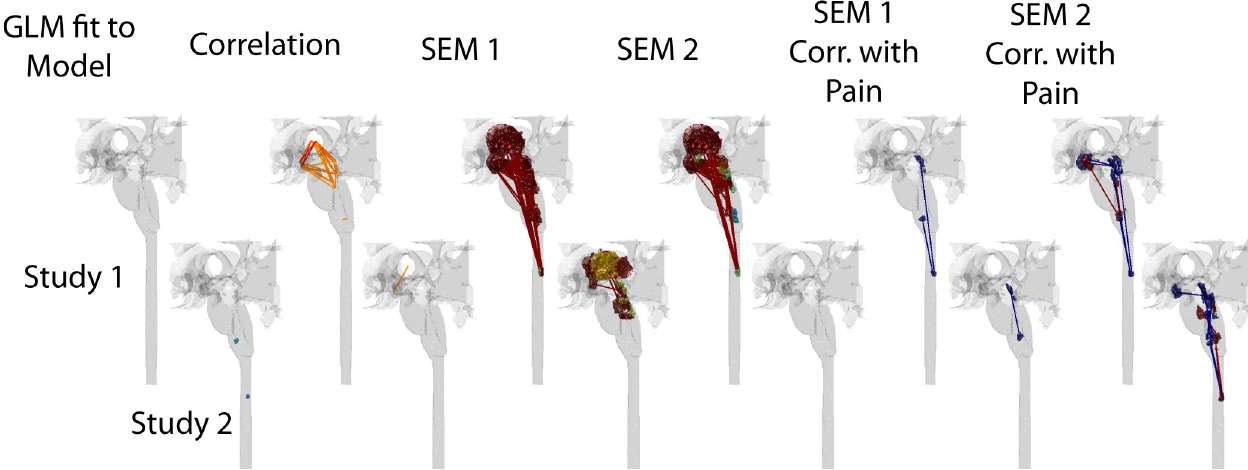
Fig 4. Anatomical regions identified with the analysis methods tested in BS and SC regions. Regions are shown for the GLM fit, connections are shown for correlation results, and both regions and connections are shown for SEM results. “GLM fit to Model” refers to the model-driven analysis, “Correlation” indicates connectivity analysis based on temporal correlation, SEM 1 and SEM 2 refer to structural equation modeling with 1 and 2 source regions, respectively, and “Corr. with Pain” indicates SEM results ( β -values) which are significantly correlated with pain ratings from each participant.